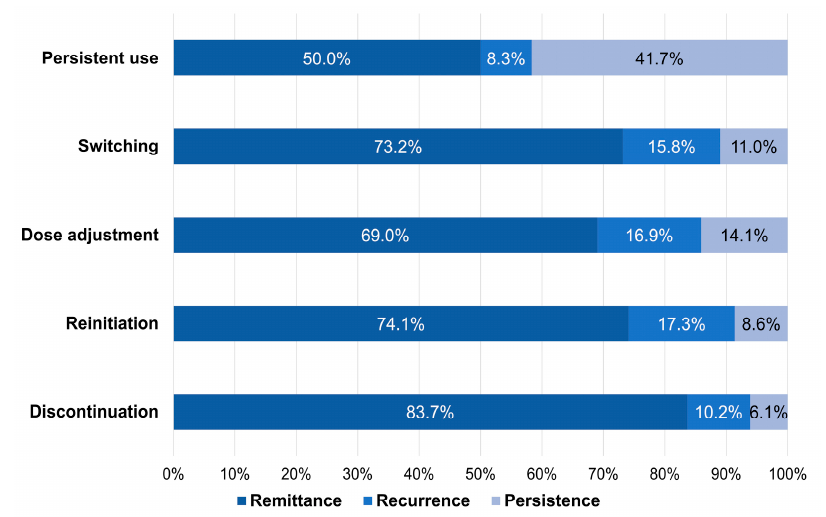
Figure 4. Prognosis by treatment patterns after incident drug ‐ induced parkinsonism.